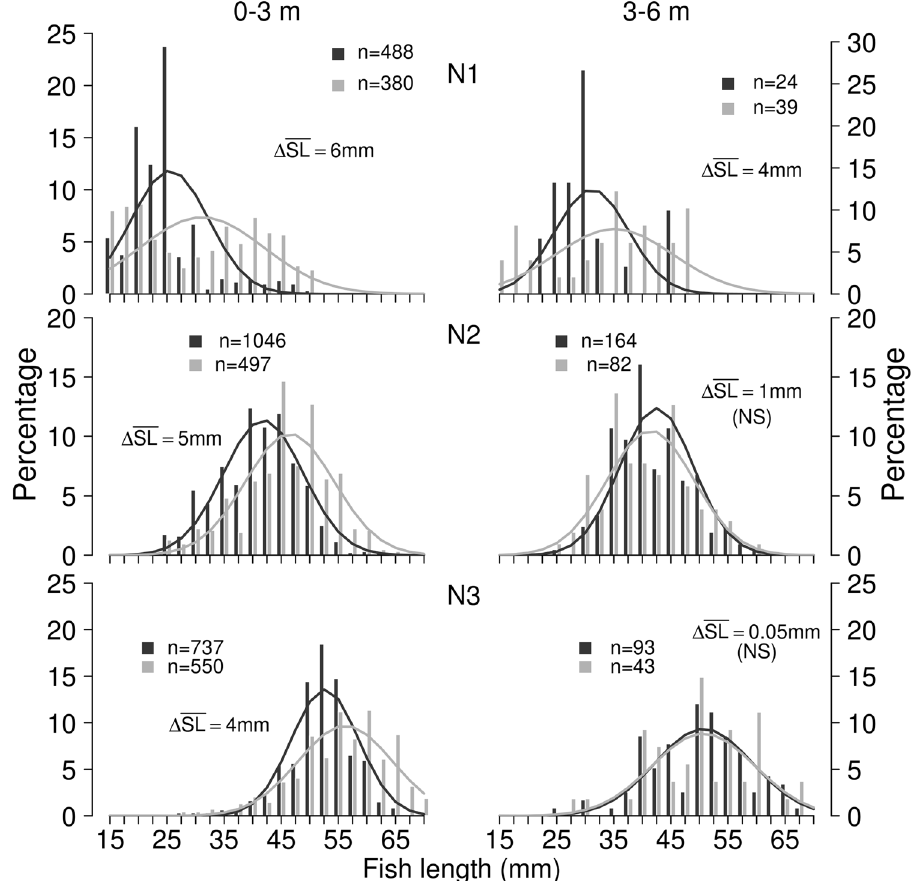
Figure 1. Length frequency distribution of juvenile fish on each night. Numbers of fish in the trawl catches (black) and tracked fish in the 38 kHz acoustic records (grey) are provided for each night and each depth layer. Δ TL stands for the difference between average acoustic and trawl length. NS – nonsignificant